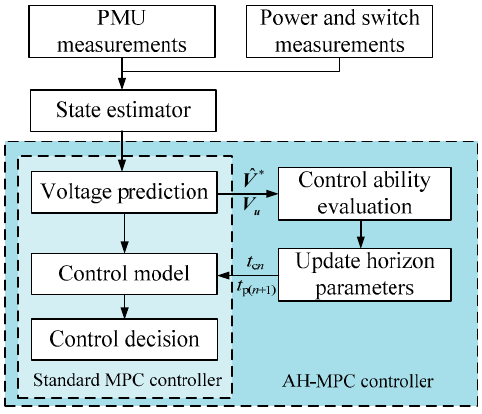
Figure 4. Structure of the voltage correction scheme based on adaptive horizon model predictive control (AH-MPC).